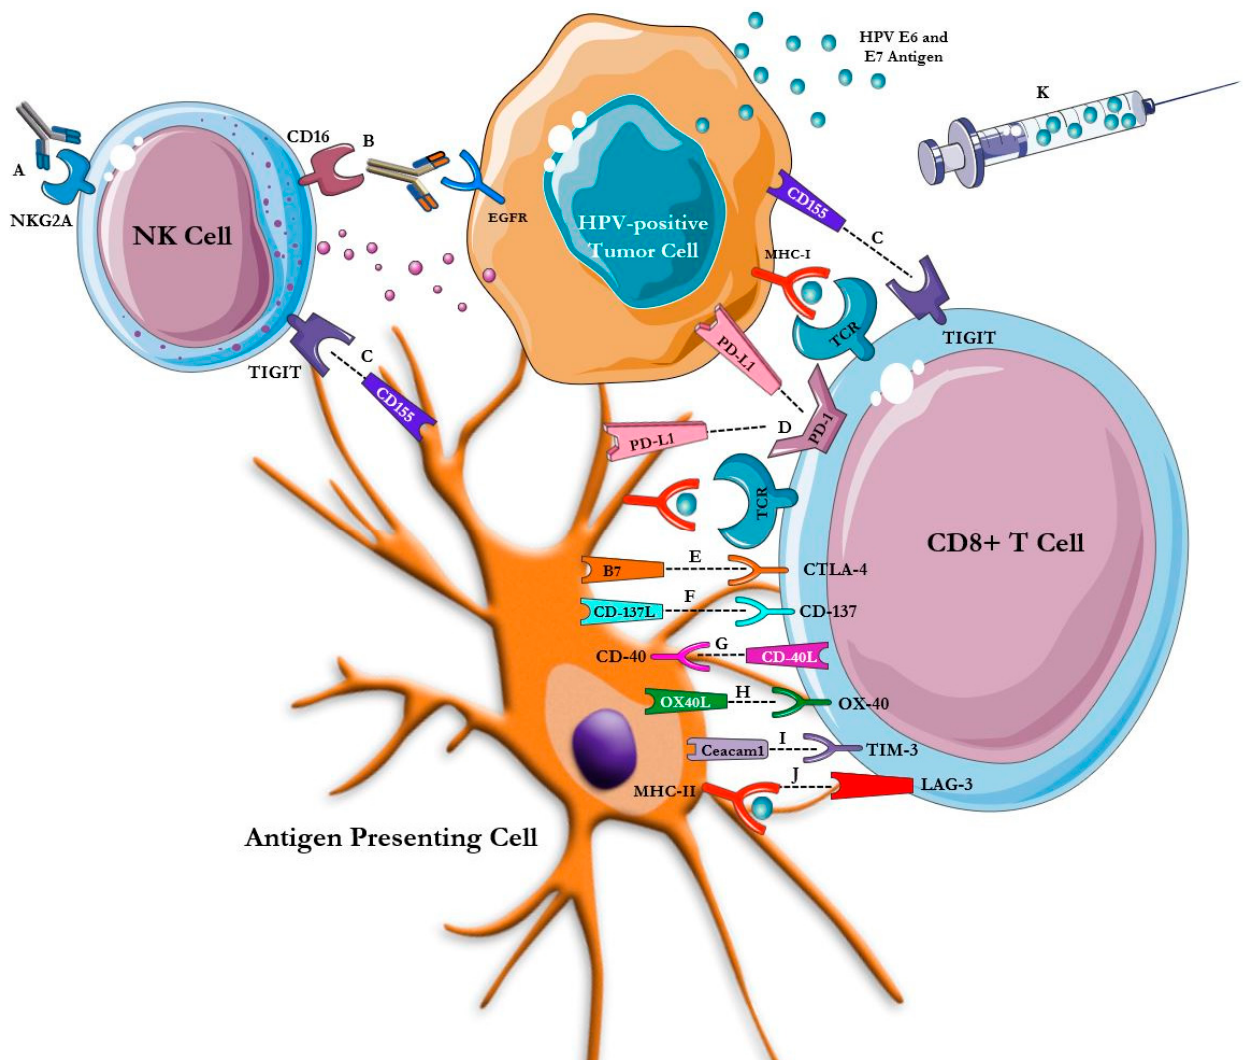
Figure 1. Mechanisms of Standard and Novel Immunotherapies in HPV-Positive HNSCC. The schema is a simplified illustration of the sites of action of novel immunotherapies within the tumor microenvironment of HPV-positive HNSCC. Monalizumab (A) is an anti-NKG2A mAb that augments the cytotoxic activity of NK cells. The Fc tail of cetuximab (B) and other IgG1 mAb can bind CD16 (the Fc receptor) on NK cells, triggering antibody-dependent, cell-mediated cytotoxicity. Tiragolumab (C) is a human anti-TIGIT mAb that prevents TIGIT from binding with its ligand, CD155, on dendritic and tumor cells. Nivolumab and pembrolizumab are mAb directed against the PD-1 receptor, while durvalumab and atezolizumab are mAb directed against its ligand, PD-L1 (D). Ipilimumab and tremelimumab (E) are mAb directed against CTLA-4. Urelumab and utomilumab (F) are mAb agonists of CD137. CP-870,8893 (G) is an agonist anti-CD40 mAb that activates CD40. MEDI6469 (H) is a murine-human OX40 agonist mAb. MBG453 (I) is a high-affinity, humanized IgG4 antibody targeting TIM-3. Eftilagimod alpha (J) is a is a soluble LAG-3 fusion protein that mediates antigen presenting cell activation and CD8 T-cell activation by binding to a subset of MHC class II molecules. Immunotherapeutic vaccines including MEDI0457, ISA-101, ADXS11-001 and TG4001 (K) incorporate HPV16 E6 and E7 antigens.